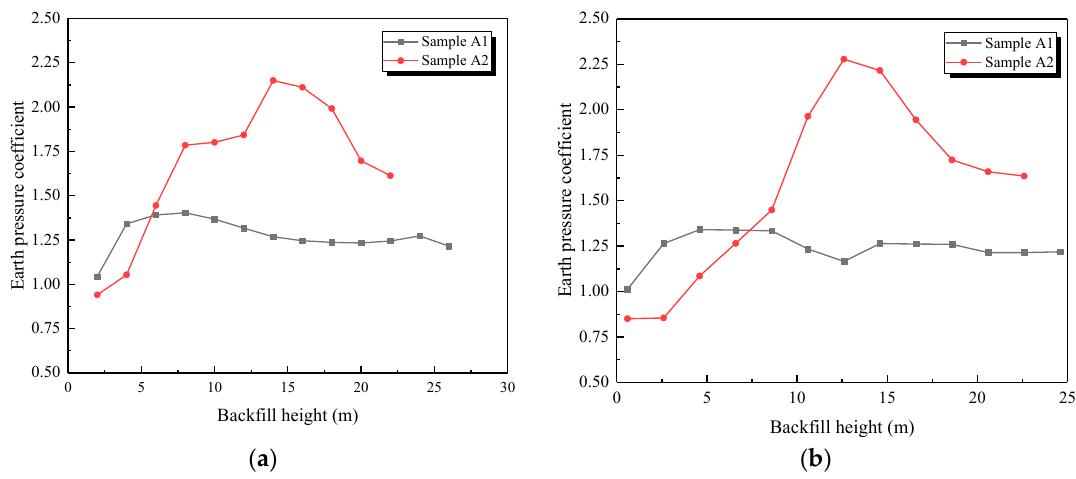
Figure 17. Variation of earth pressure coefficient during the backfilling process. ( a ) Arch crown; ( b ) Arch rib.